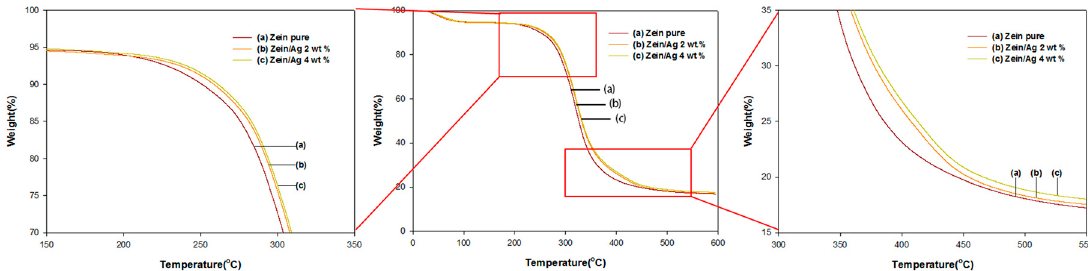
Figure 5. Thermogravimetric analysis data of zein/Ag nanoparticles electrospun from ethanol aqueous solutions with an ethanol/water ratio of 8/2 ( v/v ) at Ag concentrations of ( a ) 0, ( b ) 2 and ( c ) 4 wt % (polymer concentration = 10 wt %, TCD = 15 cm, and applied voltage = 15